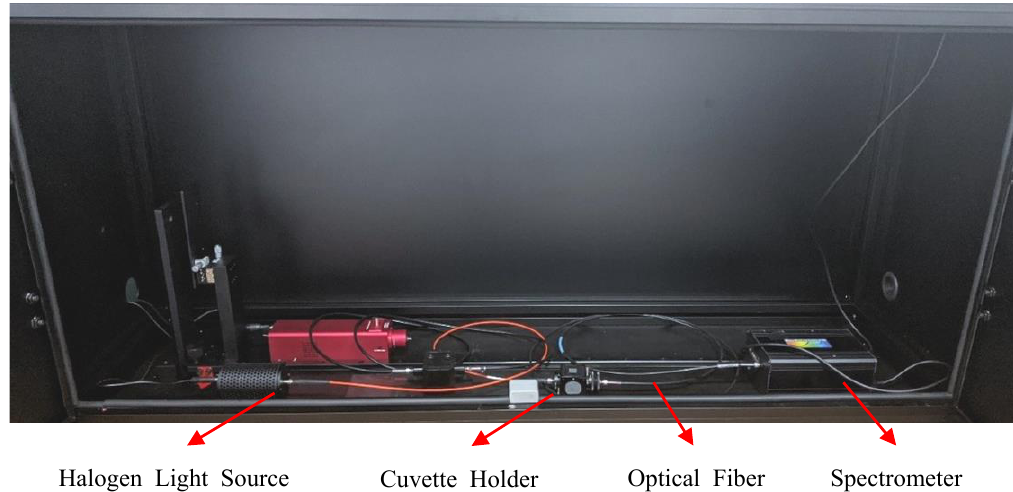
Figure 4. Experimental setup for the measurement of the molar absorption coefficient of HbA1c.